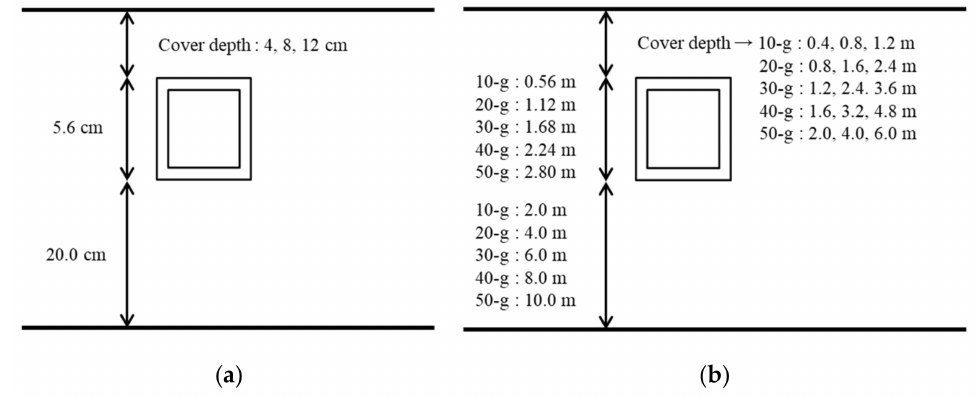
Figure 7. Diagram of box culvert: ( a ) scaled model in centrifuge model test and ( b ) actual